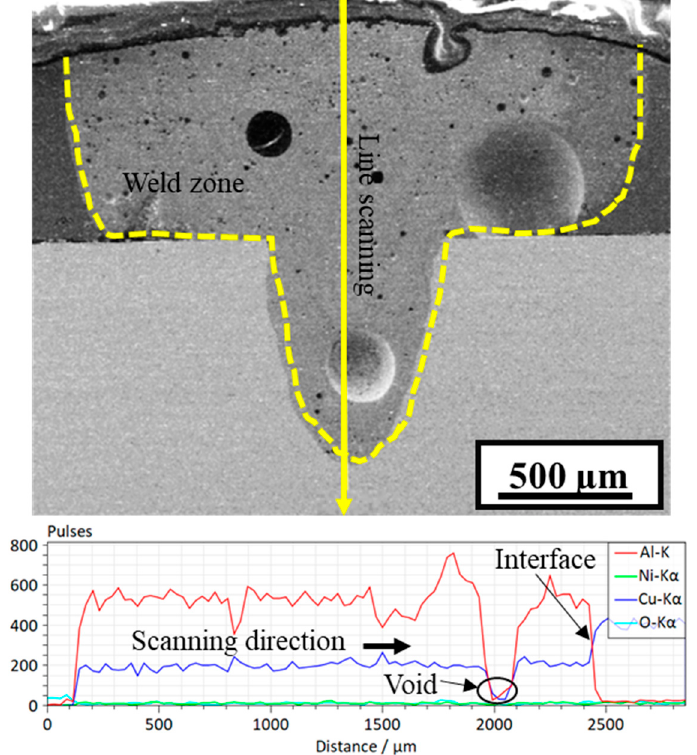
Figure 13. SEM/EDS vertical line scan of sample C2 (power = 1700 W, welding speed = 20 mm/s). Based on the SEM and EDS results, sample C2 took the highest heat input, while sample A4 took the lowest heat input. With the increase in heat input by altering the welding parameters, the diffusion kinetics increased, enhancing the amount of Cu inside the weld zone. Furthermore, the penetration depth of the melted Al also increased with heat input. Although the high heat input increased the penetration depth of the weld metal into Cu, it also introduced a higher amount of weld defects, such as porosity and weld